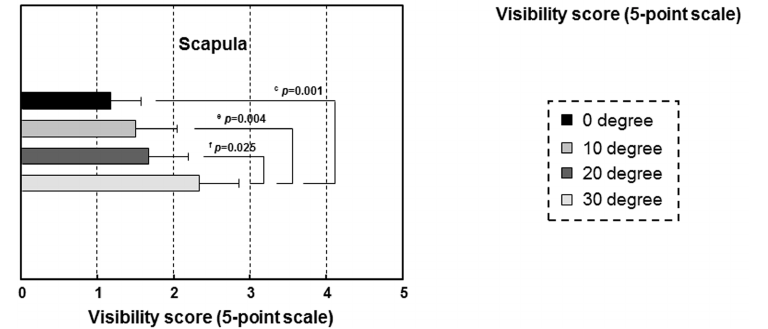
Figure 7. Mean anatomic landmark visibility scores according to different angle degrees. The significant difference between different angle degrees was analyzed with repeated-measures ANOVA and Tukey’s post hoc test: a 0 vs. 10; b 0 vs. 20; c 0 vs. 30; d 10 vs. 20; e 10 vs. 30; and f 20 vs. 30. Note that the scores including the border of the heart, the fifth rib and the scapula were significantly different from angle degrees ( p < 0.05). Five-point scale: 1, definitely seen; 2, probably seen; 3, equivocal; 4, probably not seen; and 5, definitely not seen.